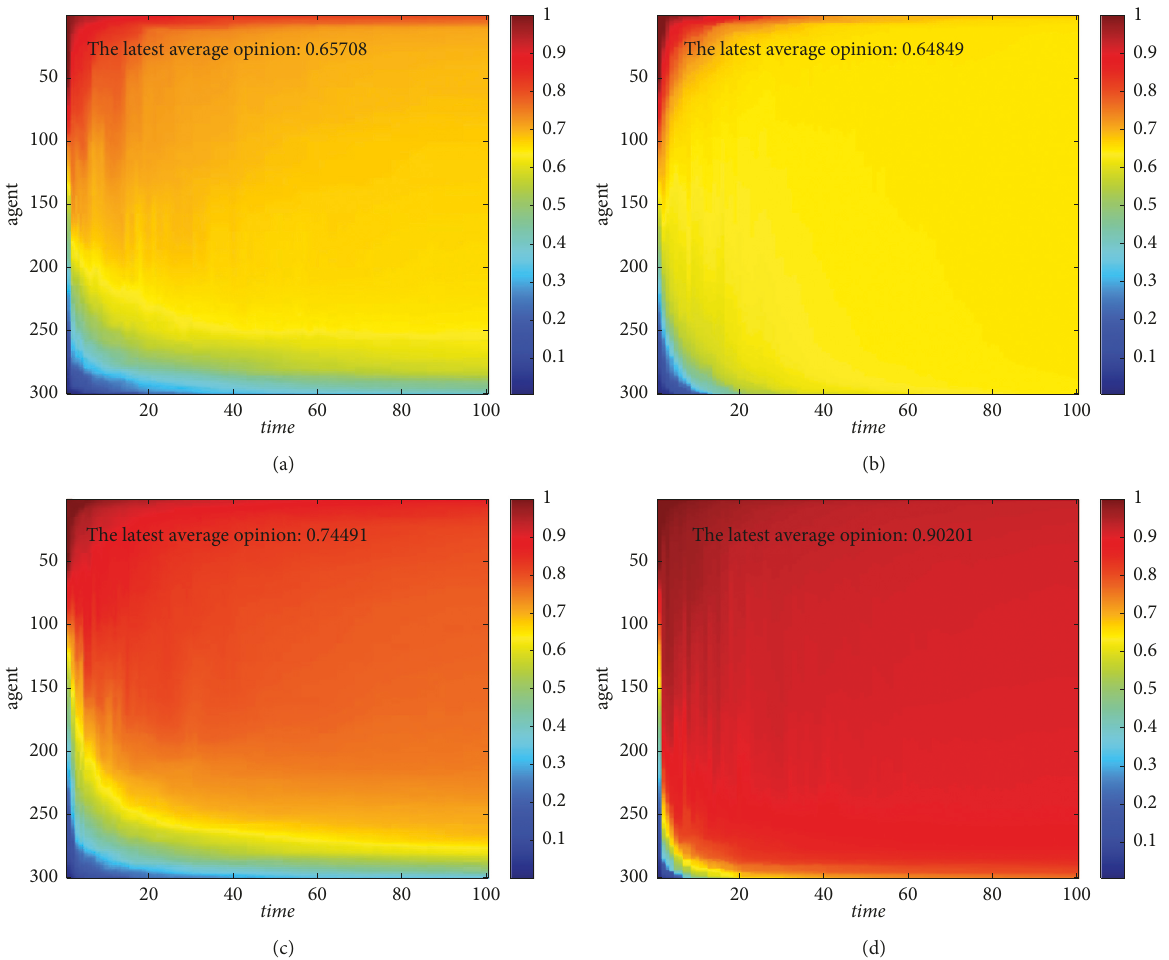
Figure 4: Comparison of guiding effect of key agents in different situation under wide spreading, target opinion is 1. (a) Case A. (b) Case B. (c) Case C. (d) Case